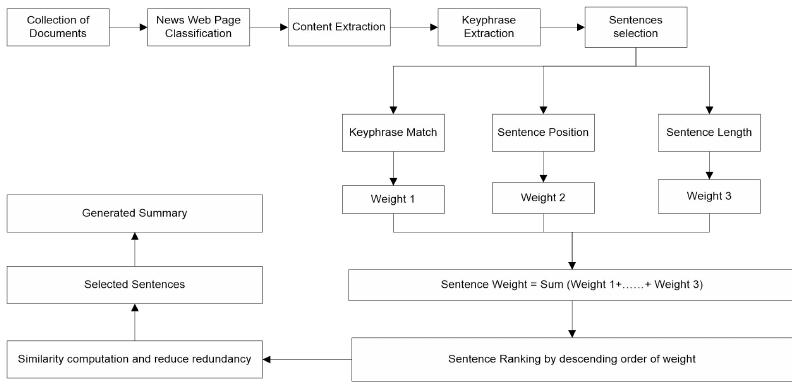
Figure 1. Architecture of news summarization system.